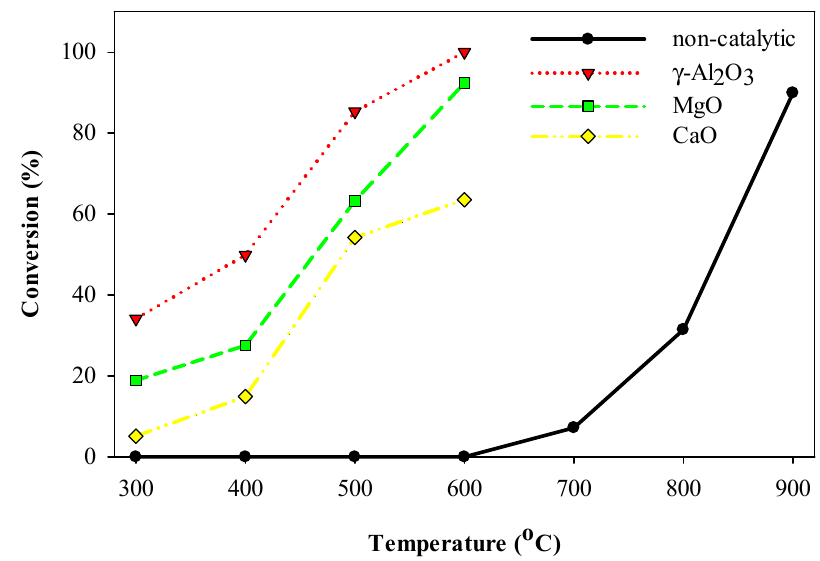
Figure 1. Short-term conversion efficiencies of HFC-134a obtained from the non-catalytic and catalytic conversion of HFC-134a over γ -Al 2 O 3 , MgO, and CaO at different temperatures.